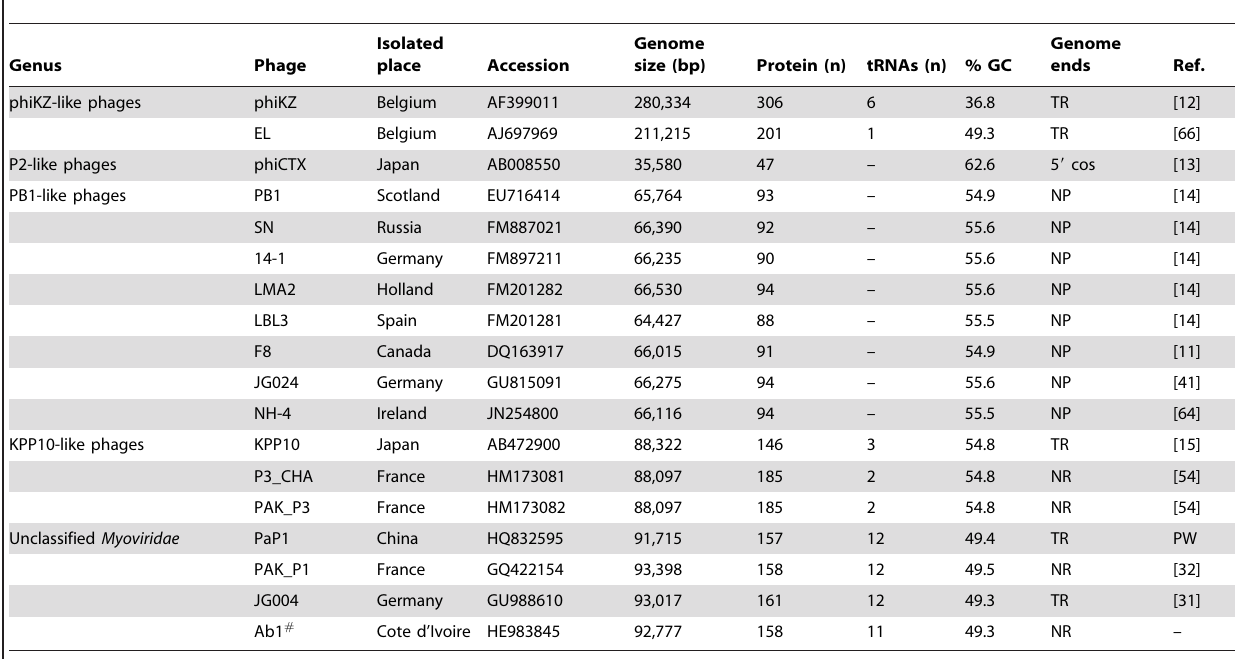
Data listed in the table are mainly obtained from the public genome sequences as of 28 Oct. 2012. TR: Terminally redundant, NP: Non-permuted, cos: Cohesive ends, NR: Not reported, PW: Present